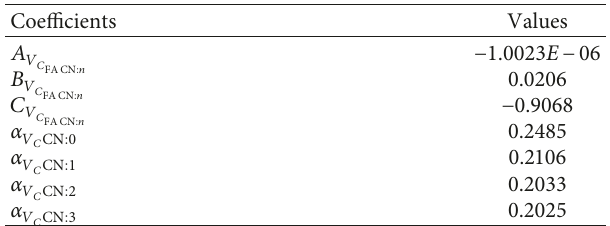
Table 20: Coefficients for the estimation of the critical volume according to equation (38).